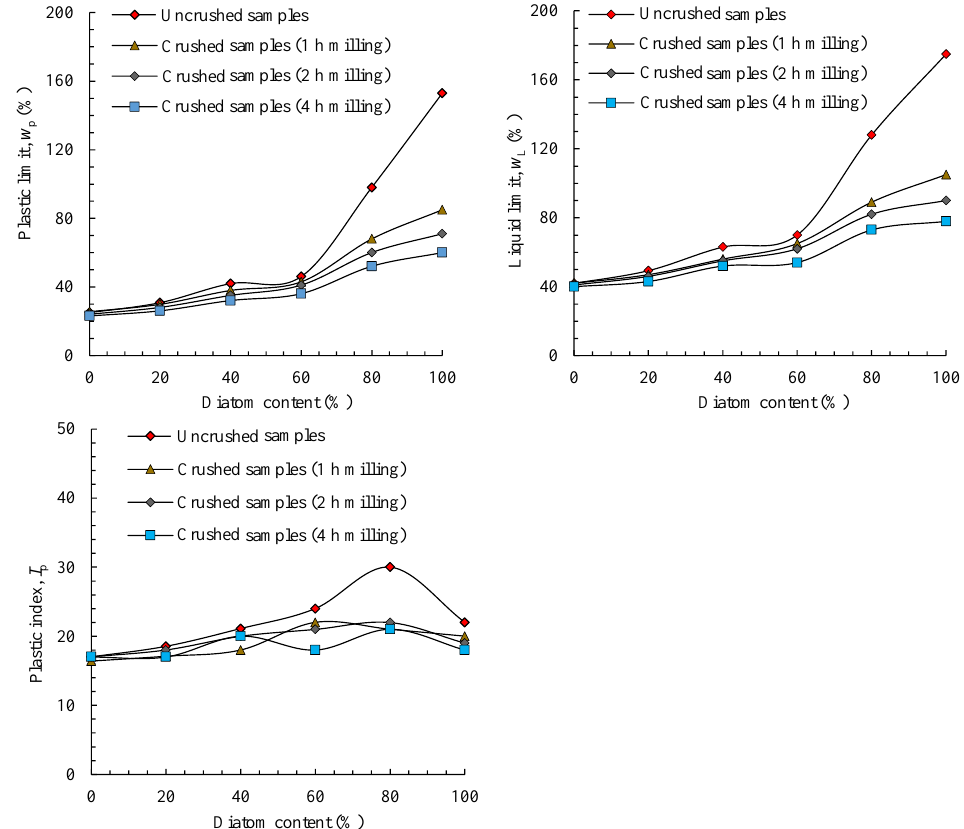
Figure 9. Values of w p , w L , and I P for DKM samples with different diatom contents.